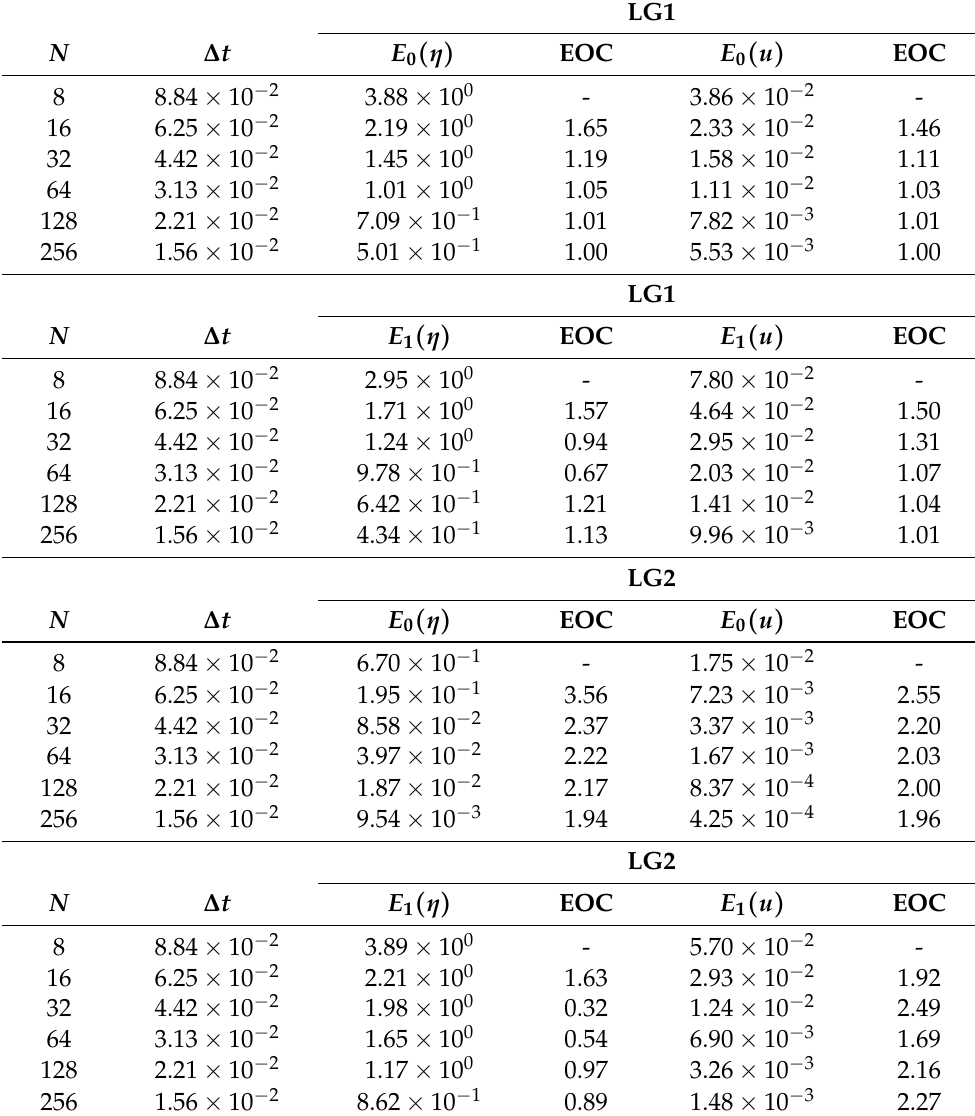
Table 2. Values of E i ( η ) and E i ( u ) , i = 0,1, by schemes LG1 and LG2 for Example 2 ( Γ = Γ D ∪ Γ T